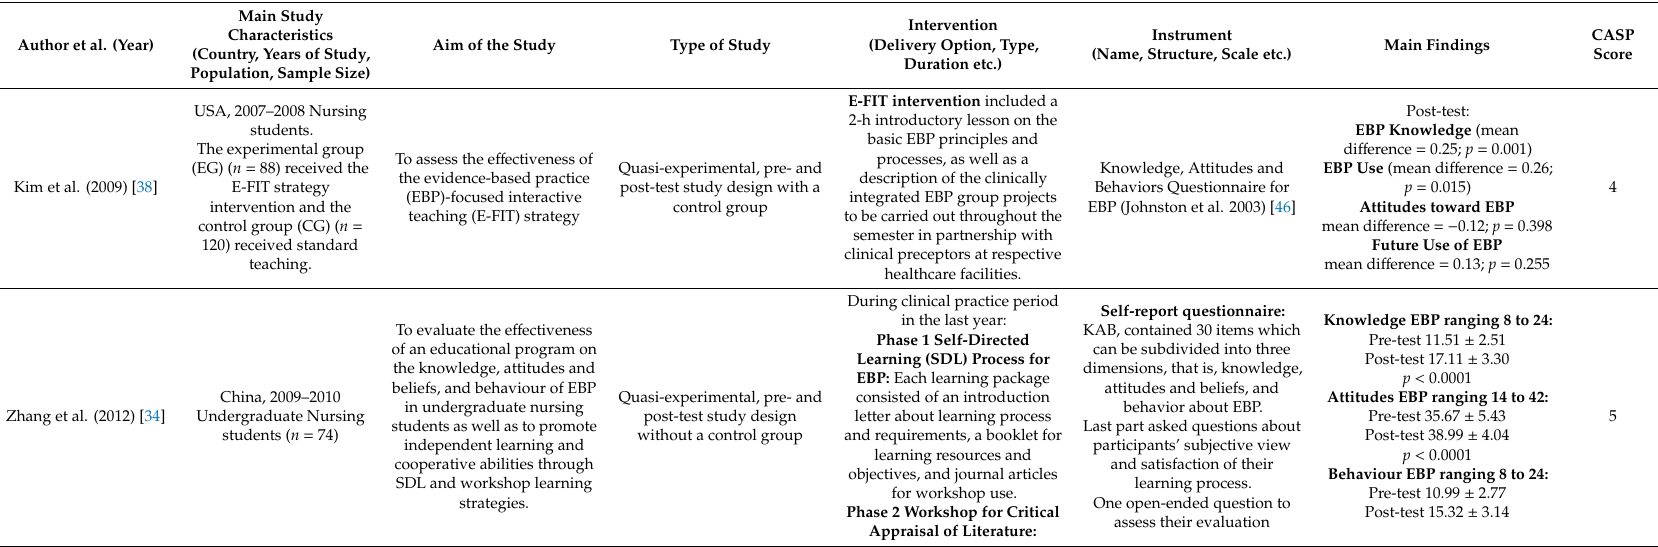
Table 2. Data extraction for face to face used method to teach